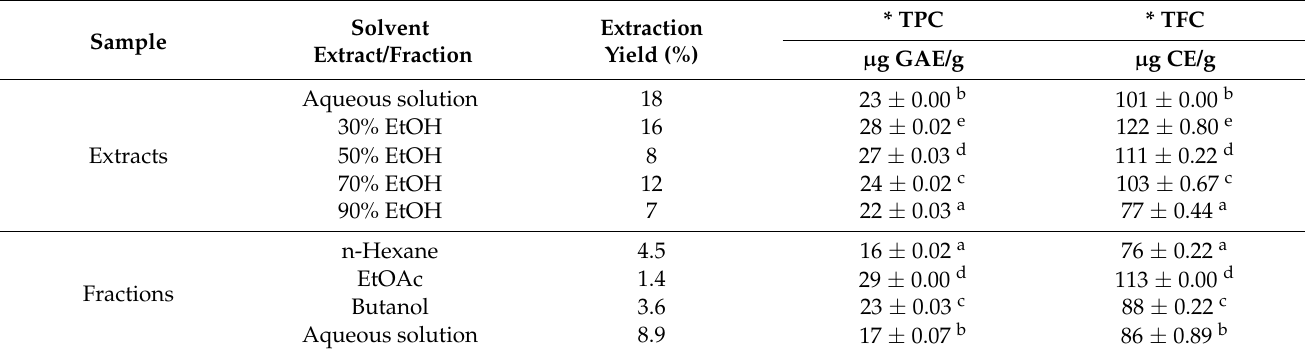
Table 1. Total phenolic and flavonoid content of P. thunbergiana L. extracts and fractions. Results are expressed as mean values ± standard deviation ( n = 3). Means with different superscript letters ( a–e ) indicate statistically significant differences ( p <